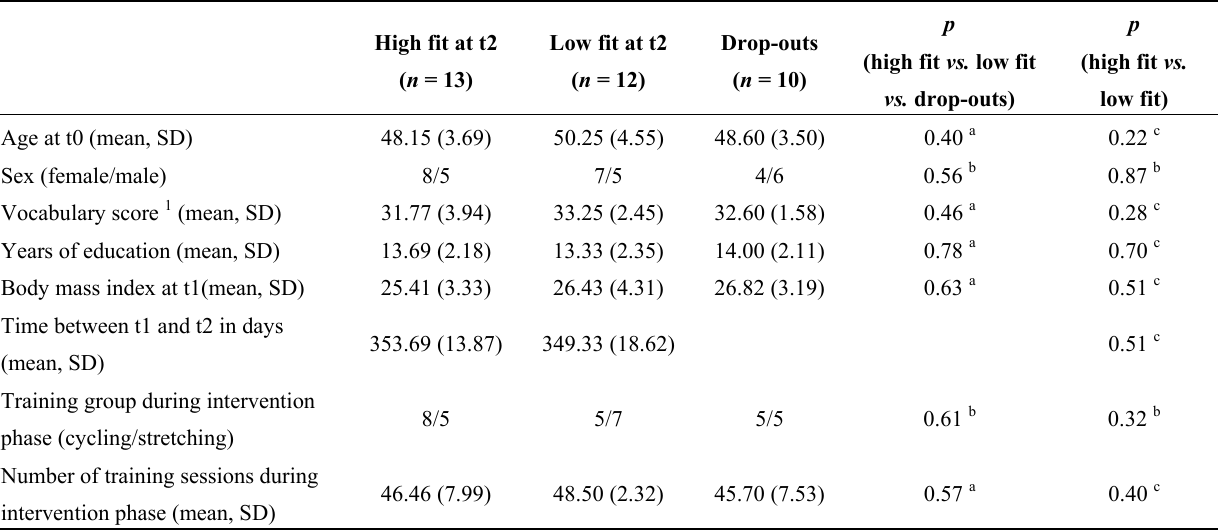
Table 1. Participants’ characteristics separated by participants with high cardiovascular fitness vs . low cardiovascular fitness at t2 and